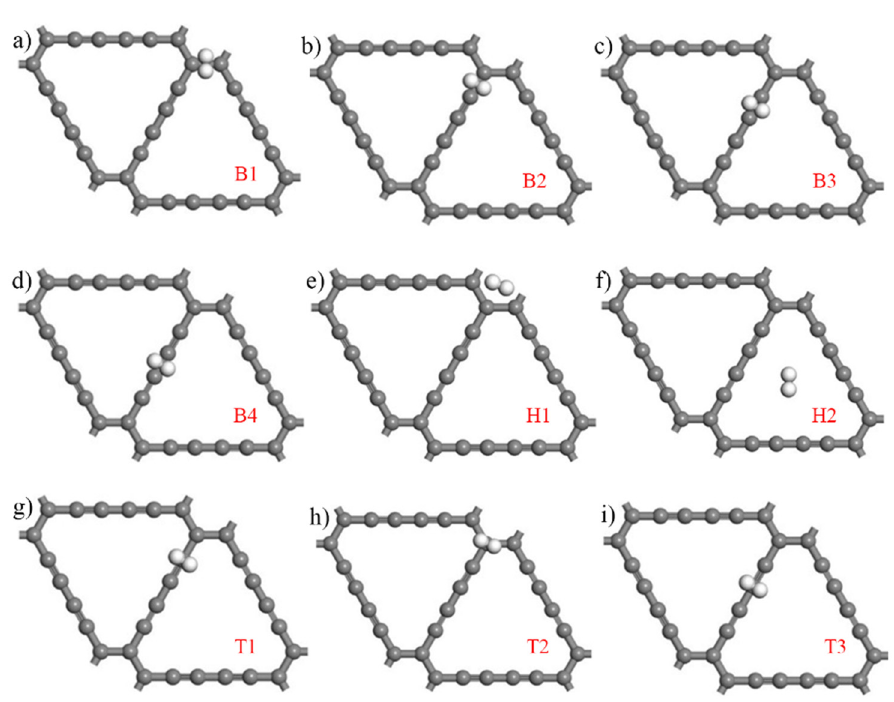
Figure 5. Hydrogen adsorption models of intrinsic γ -GDY at nine highly symmetric adsorption points. (Hydrogen molecules are expressed by white balls, ( a – i ) represent the hydrogen molecule adsorption points B1, B2, B3, B4, H1, H2, T1, T2 and T3, respectively). Table 2. Hydrogen adsorption height and adsorption energy of nine points.